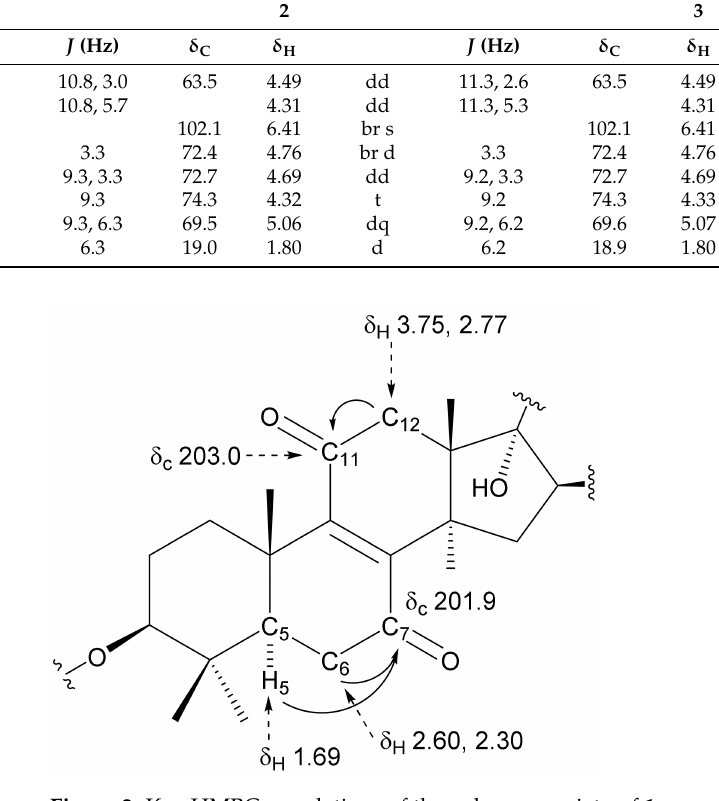
Figure 2. Key HMBC correlations of the aglycone moiety of 1 . The 1 H and 13 C NMR spectral features of 2 (C 50 H 80 O 20 ) and 3 (C 50 H 80 O 20 ) were closely related to those of 4 . However, when the 13 C NMR spectra of 2 and 3 were compared with that of 4 , the signal assignable to the hemiacetal carbon at δ C 97.7 (C-23) in 4 was shifted downfield by 12.7 ppm in 2 and 6.2 ppm in 3 , and observed at δ C 110.4 in 2 and at δ C 103.9 in 3 . The 1 H NMR spectra of 2 and 3 displayed a deshielded methyl singlet signal at δ H 3.49 and δ H 3.42, respectively (Table 1). In the HMBC spectrum of 2 , the methyl singlet at δ H 3.49 showed a long-range correlation with C-23 at δ C 110.4. Additionally, the methyl singlet at δ H 3.42 exhibited an HMBC correlation with C-23 at δ C 103.9 in 3 . These data indicated that the hemiacetal moiety of 4 was changed to the methyl acetal in 2 and 3 . In the NOESY spectrum of 2 , NOE correlations between H-23 and H-24 and between H-22 and C 23 -OMe/Me-27, and a spin-coupling constant of 3 J H-22,H-23 = 6.3 Hz showed the configuration at C-23 to be α in 2 . On the other hand, NOE correlations between C 23 - OMe and H-20/H-24 and between H-23 and H-22/Me-27, and a spin-coupling constant of 3 J H-22,H-23 = 5.8 Hz gave evidence that 3 was the C-23 epimer of 2 . The triglycoside moiety attached to C-3 of the aglycone of 2 and 3 was ascertained to be the same as that of 4 by the analysis of the HMBC spectra of 2 and 3 . Therefore, 2 and 3 were identified as 23 α -methyl-peruvianoside A and 23 β -methyl-peruvianoside A. The 1 H NMR spectrum of 12 (C 30 H 38 O 15 ) was essentially analogous to that of the homoisoflavanone ( 14 ), showing signals for two methylene groups at δ H 4.36 (dd, J = 11.5, 4.0 Hz, H-2a) and 4.19 (dd, J = 11.5, 6.5 Hz, H-2b), and δ H 3.13 (dd, J = 14.0, 9.0 Hz, H-9a) and 2.72 (dd, J = 14.0, 7.0 Hz, H-9b), a methine proton at δ H 2.96 (m, H-3), 1,4-disubstituted aromatic ring at (cid:48) and H-6 (cid:48) ) and 6.86 (d, J = 8.5 Hz, H-3 (cid:48) and H-5 (cid:48) ), and an aromatic δ H 7.16 (d, J = 8.5 Hz, H-2 proton at δ H 6.31 (s, H-8), and two methoxy groups at δ H 3.77 (s) and 3.75 (s) (Table 3). Furthermore, signals for two anomeric protons and carbons were observed at δ H 4.96 (d, J = 7.5 Hz); δ C 101.7 and δ H 4.68 (br s); δ C 102.2. The enzymatic hydrolysis of 12 gave 5,7-dihydroxy-6-methoxy-3-(4 (cid:48) -methoxybenzyl)-chroman-4-one ( 12a ) [19] and D